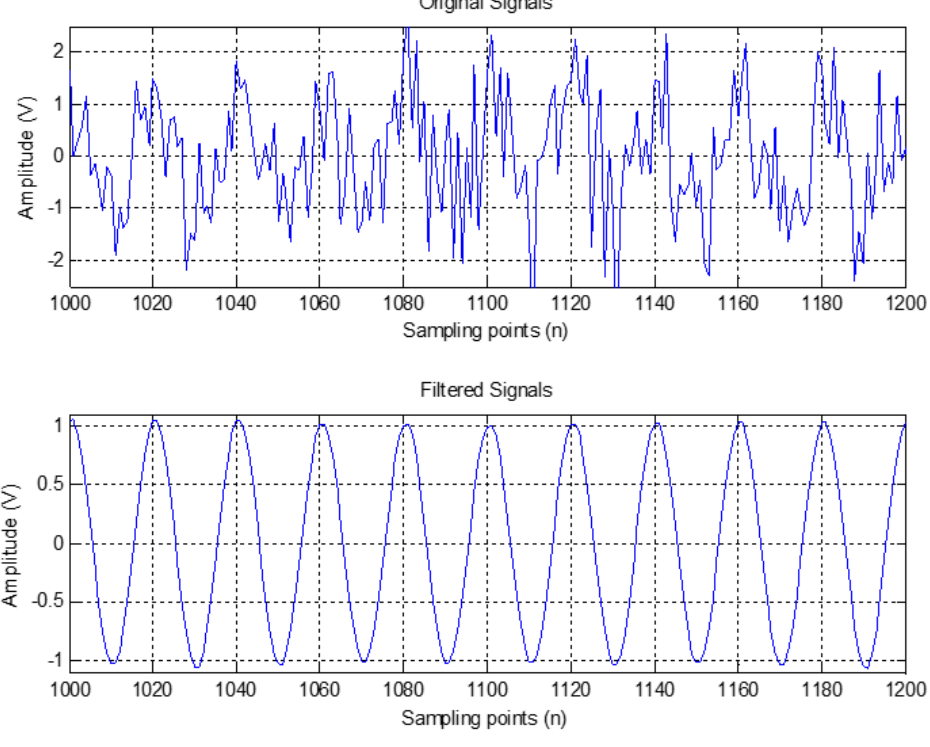
Figure 1. Original signals and filtered signals.